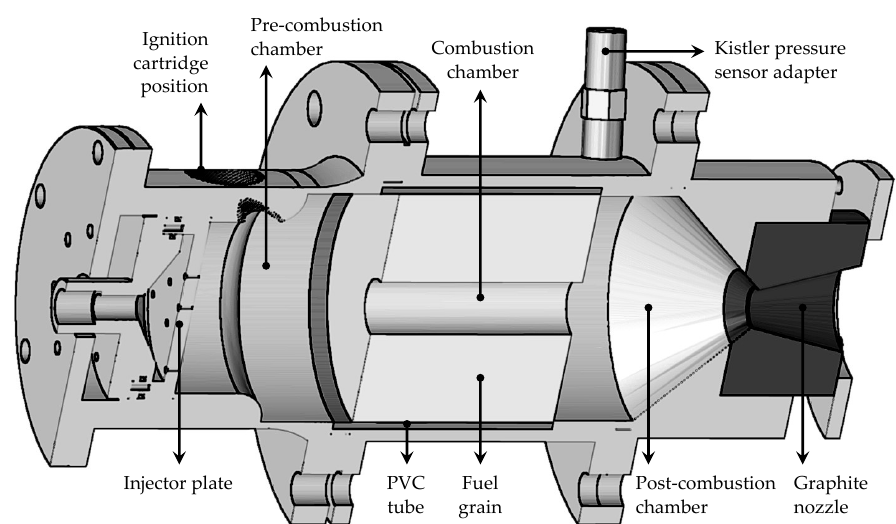
Figure 5. A 3D cut of the ULB-HRM (as presented in [7], but reoriented